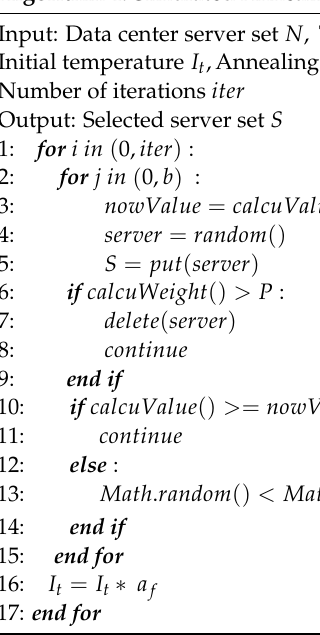
Table 2. Simulation time comparison of different algorithms.